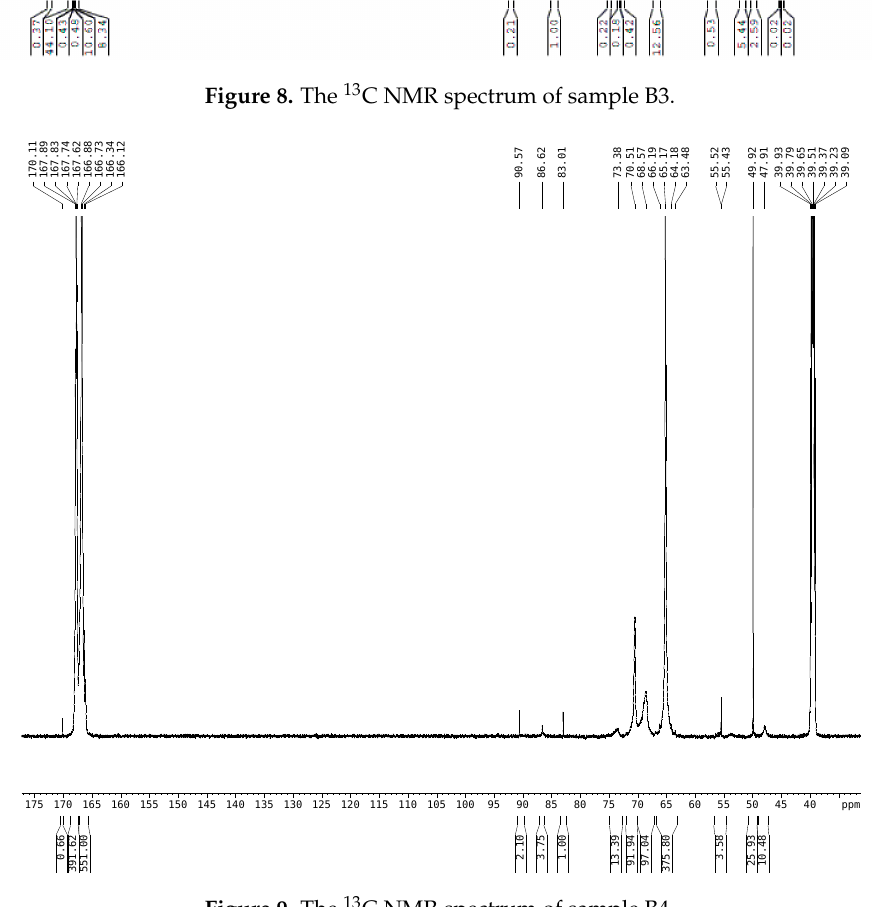
Figure 9. The 13 C NMR spectrum of sample B4.